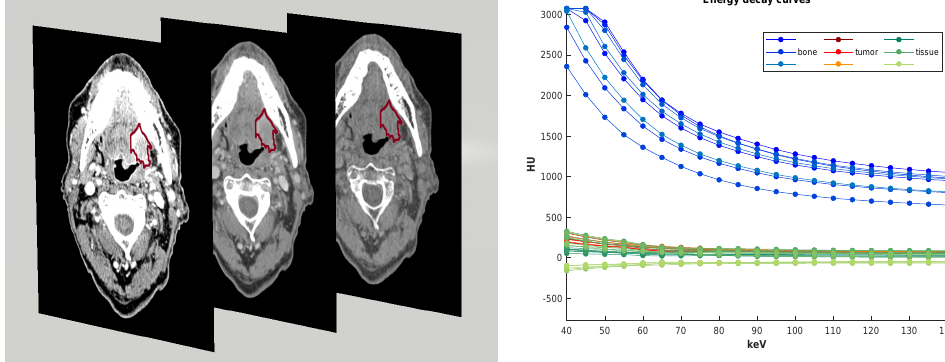
Figure 1. ( Left ) 2D slices of VMIs at 40,65,140 keV with tumor contour in red. At lower energy levels, VMIs are more constrated; at higher levels, VMIs are less noisy. A VMI at 65 keV is similar to a standard CT scan. ( Right ) Examples of decay curves for different body locations. A blue (resp. red, green) curve represents attenuation information stored at one voxel within bone (resp. tumor,